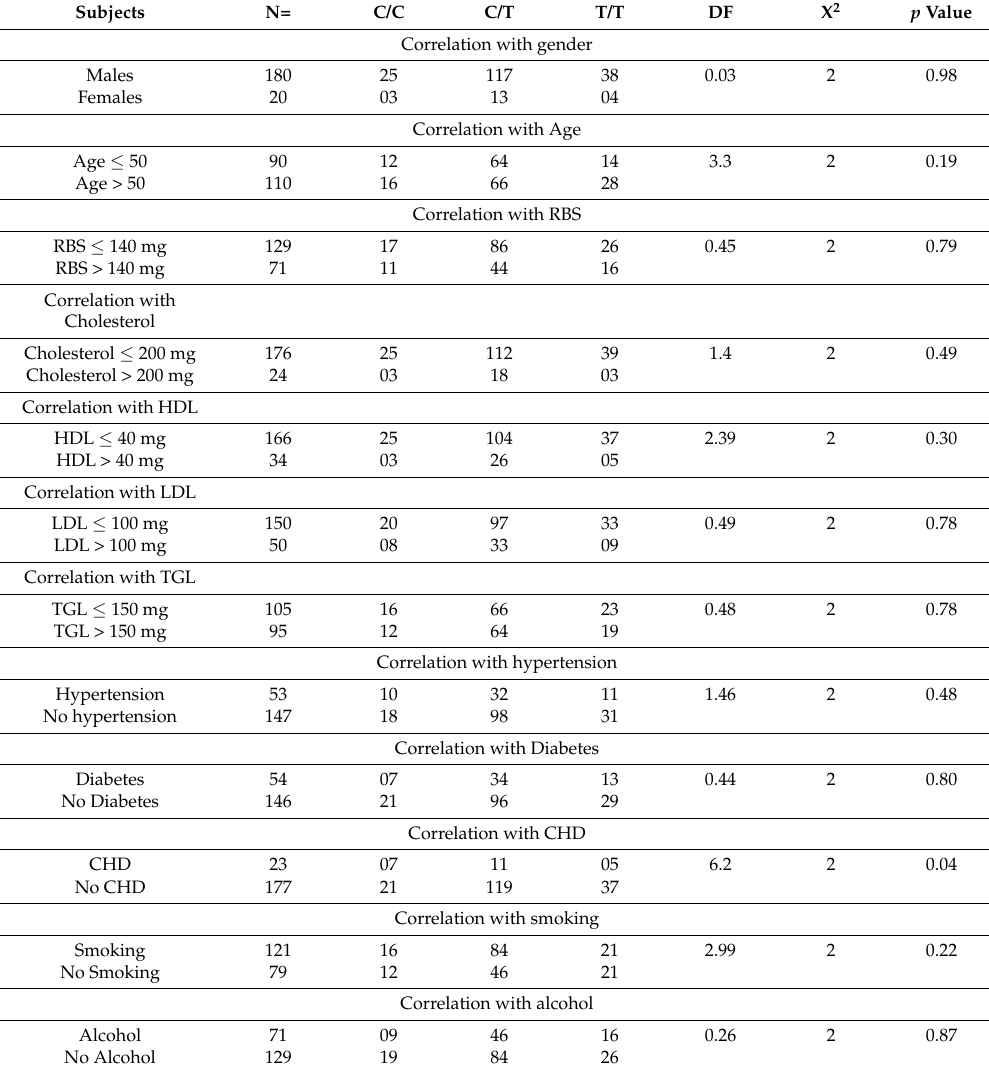
Table 4. Allele and genotype frequency of LDLR gene polymorphism of study cohorts.